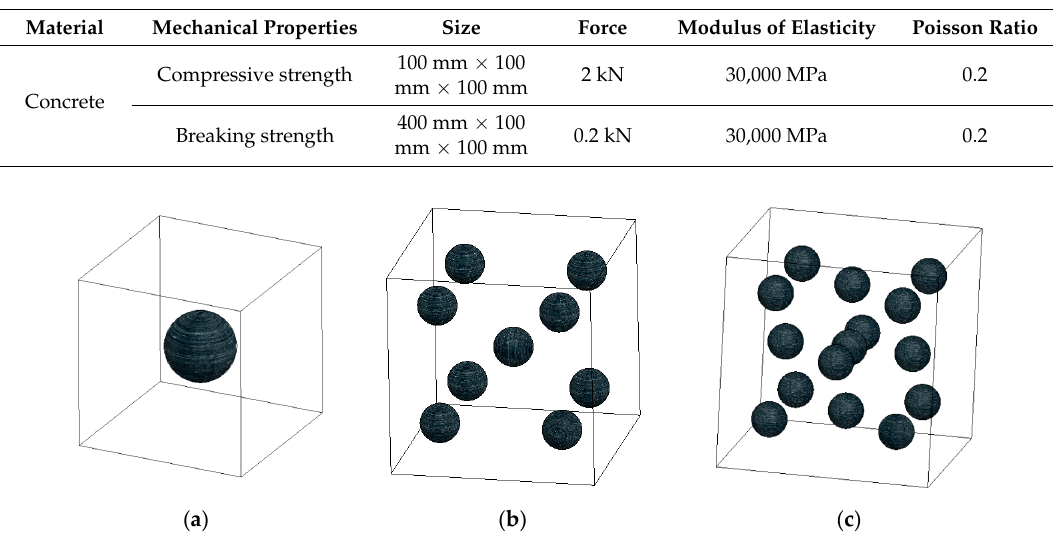
Figure 9. Model of compressive strength (Strain). ( a ) Aggregated completely, ( b ) dispersion ratio of 50%, ( c ) dispersion ratio of 100%.